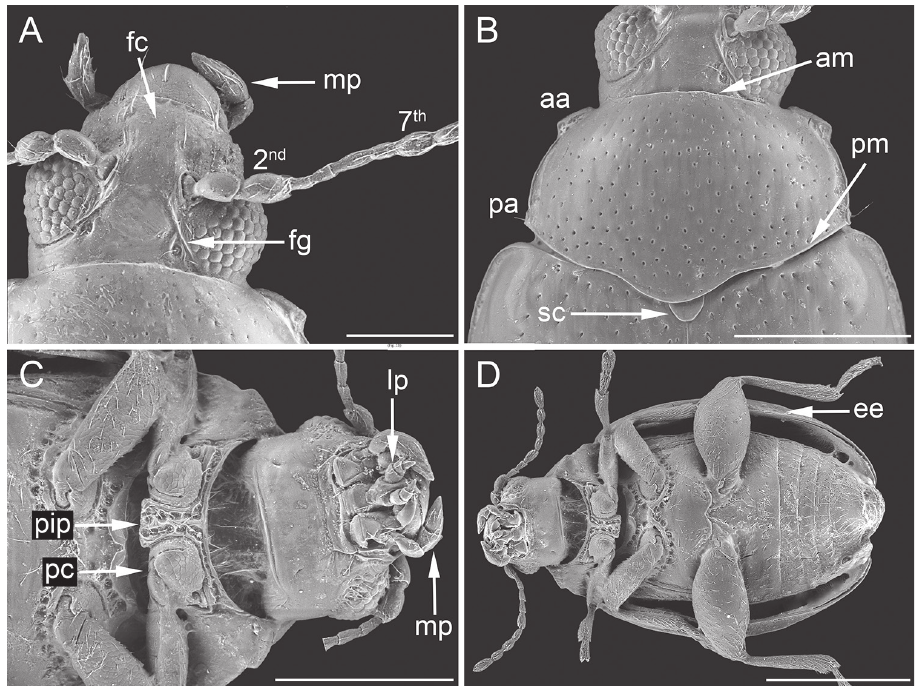
Figure 2. Morphological characters of Ugandaltica wagneri sp. n. A Head in dorsal view: 2 nd = second antennal segment, 7 th = seventh antennal segment, fc = frontal carina, fg = frontal groove, mp = maxil- lary palpus B pronotum: aa = anterior angle, am = anterior margin, pa = posterior angle, pm = posterior margin, sc = scutellum C Head in ventral view, prosternum and mesosternum: lp = labial palpus, mp = maxillary palpus, pip = prosternal intercoxal process, pc = procoxal cavity D Habitus of a female in ventral view: ee = elytral epipleurae. Scale bar: 150 µm ( A ); 300 µm ( B , C ); 500 µm ( D